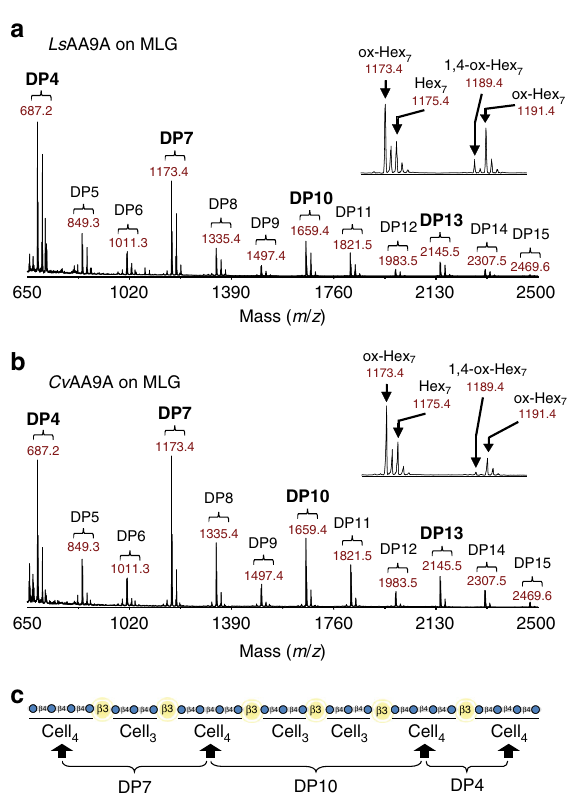
Fig. 3 Ls AA9A and Cv AA9A digestion products of MLG suggest preference for Cell 4 region cleavage. Products of Ls AA9A ( a ) and Cv AA9A ( b ) activity on barley MLG with 4 mM ascorbate were analysed by MALDI-ToF MS (performed in triplicate). Both enzymes can produce both C1 and C4 oxidation on MLG (1,4-ox; oxidized C1 and C4, see insets). Further, oligosaccharide pro fi les show a distinct pattern indicative of the mechanism of attack and substrate speci fi city of each enzyme on MLG. c Proposed region of